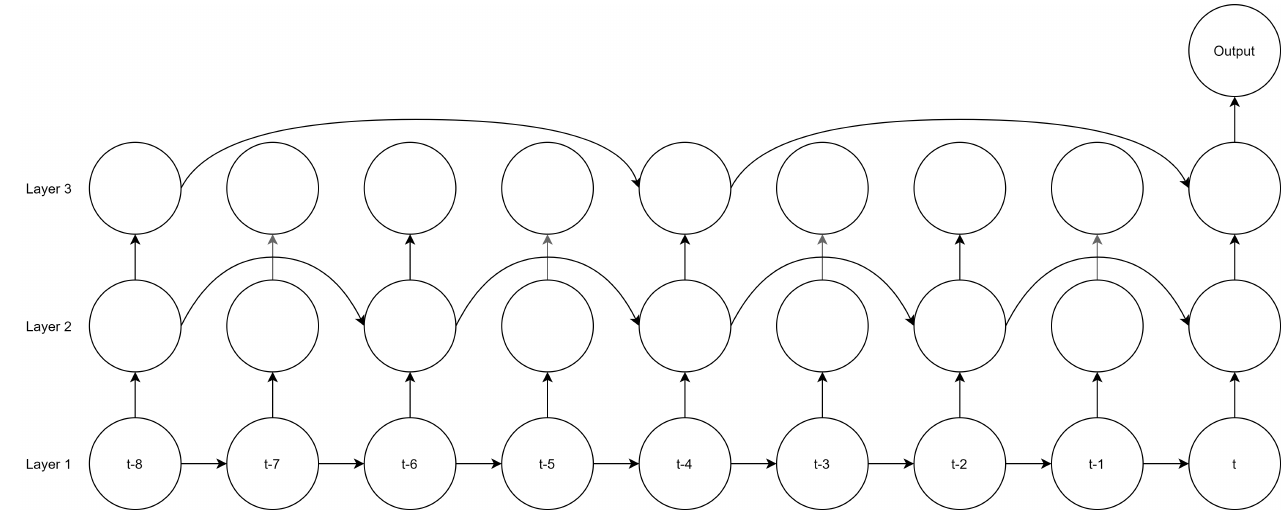
Figure 5. Zhu Dilated RNN architecture.